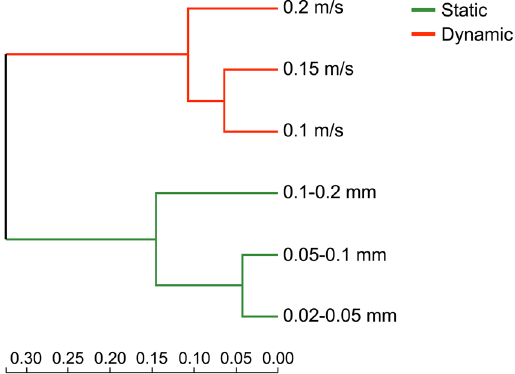
Figure 8. Hcluster tree of samples with the Bray-Curtis similarity index calculated using the abundance of genera.